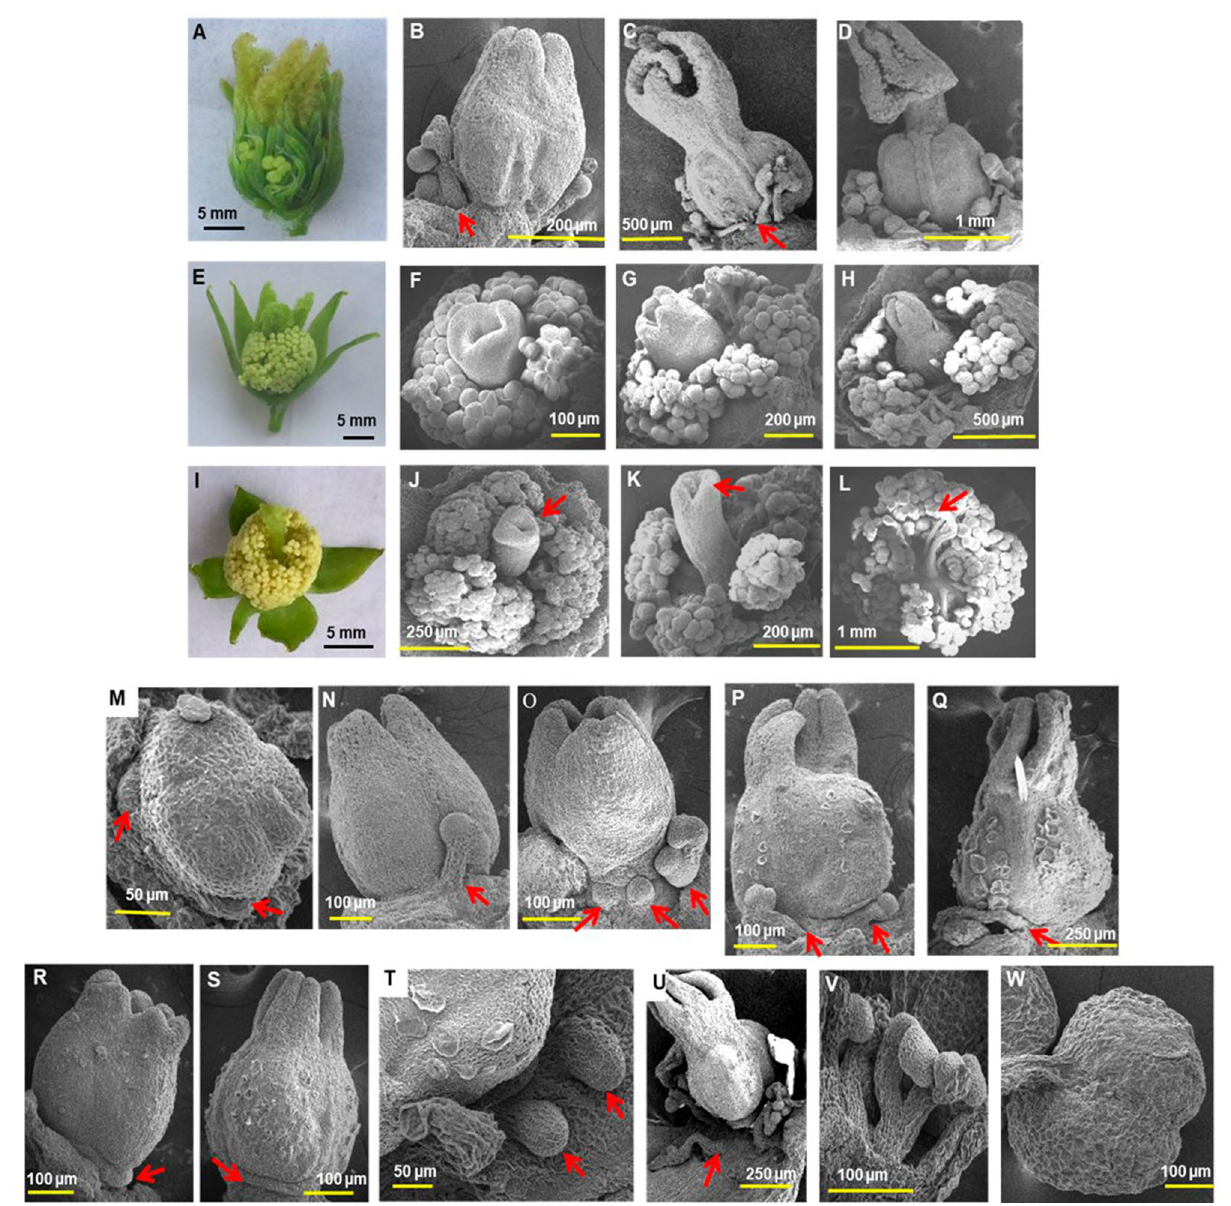
Figure 6. Bisexual flowers and reversion to bisexuality in castor. Bisexual flowers with ( A–D ) Rudimentary stamens ( E–H ) Equally developed carpel and stamens and ( I–L ) Rudimentary pistil. ( M–Q ) Reversion to bisexuality in female flowers at ( M ) stage 6 ( N,O ) stage 11 and ( P,Q ) stage 12. (R–U) Origin of rudimentary stamens. ( V ) Section of flower showing origin of rudimentary stamens. ( W ) Larger anthers in rudimentary stamens. Arrows indicate stamen primordia or rudimentary stamens ( B,C,M–V ) or rudimentary pistils ( J–L ). Scale bars are shown